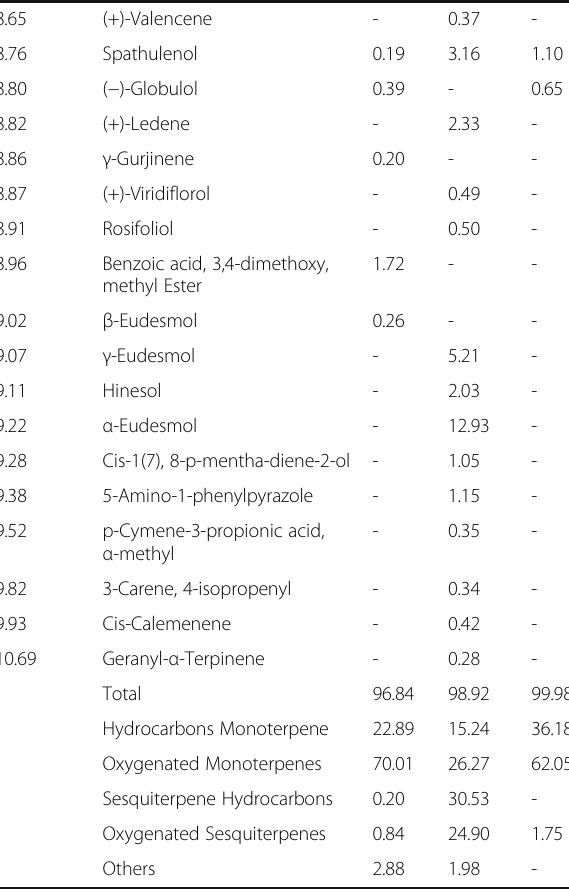
Table 1 Fractional compositions of constituents of the leaves flowers and stems oil of Callistemon citrinus